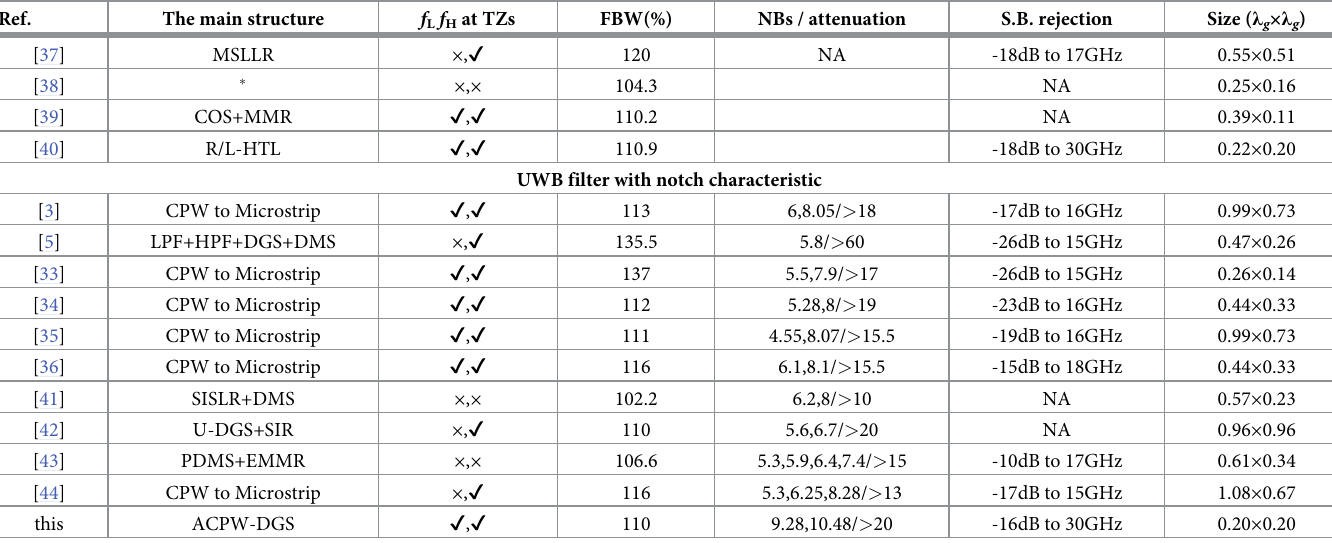
Table 6. Comparison of filter parameters between this paper and other filters. Ref. The main